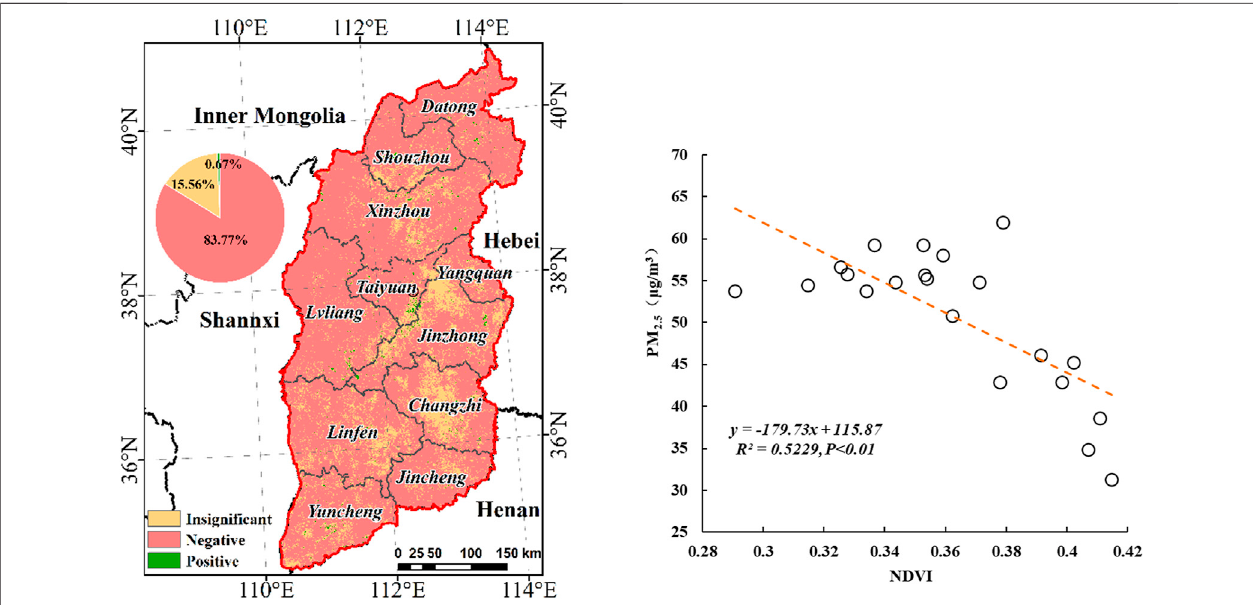
FIGURE 6 | The correlation between NDVI and PM 2.5 . The pie charts illustrate the area percentage of different spatial patterns of the correlations.